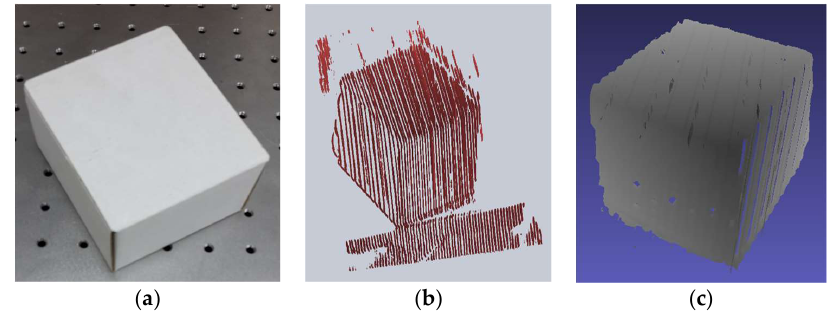
Figure 6. Results of the 3D reconstruction of a single view of the box object, ( a ) the actual box object; ( b ) Visualization of the 3D point cloud; and ( c ) Visualization of the mesh refined in the MeshLab software (ISTI, CNR, Pisa, Italy).